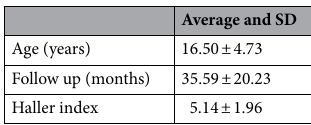
Table 1. Patient characteristics.